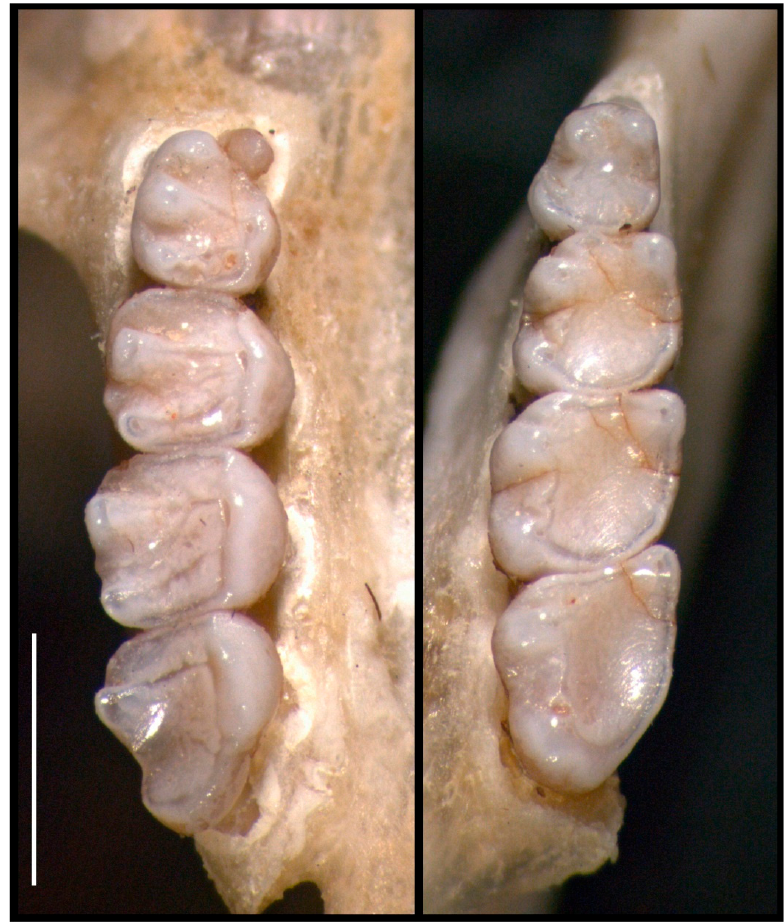
Figure 3. Right upper (to the left) and left lower (to the right) tooth rows of the specimen S-207534 from Phu Yen Province. Scale bar 2 mm.